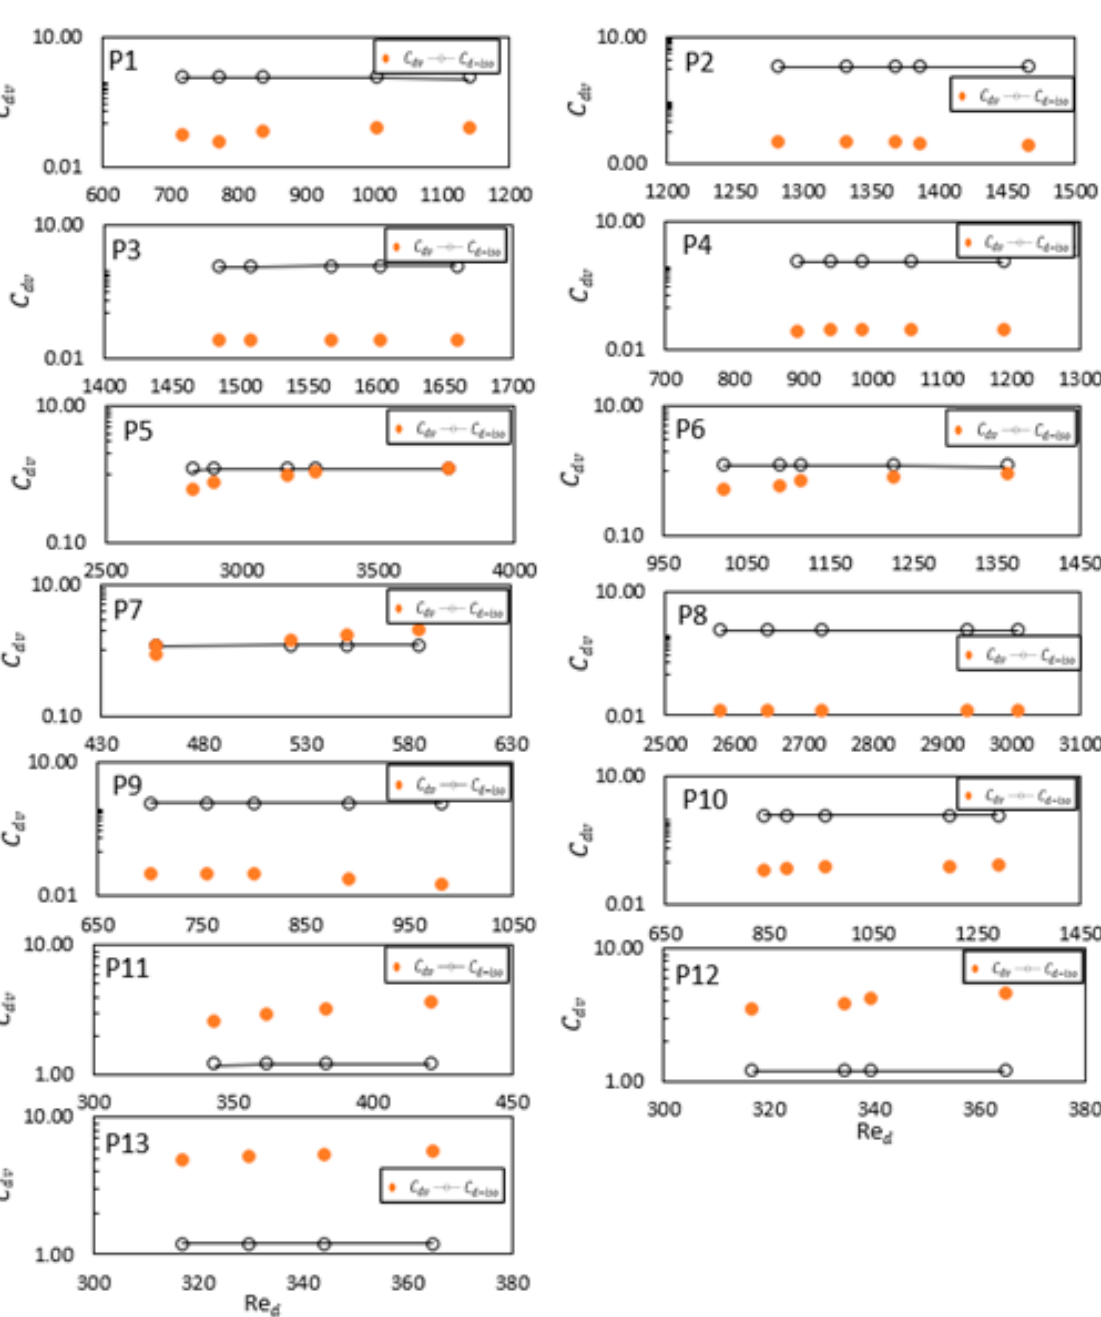
Figure 8. Variations in the drag coefficient 𝐶 (cid:3031)(cid:3049) of flexible vegetation with 𝑅𝑒 (cid:3031) = 𝑈(𝑥)𝐷/𝜗 (cid:3040)